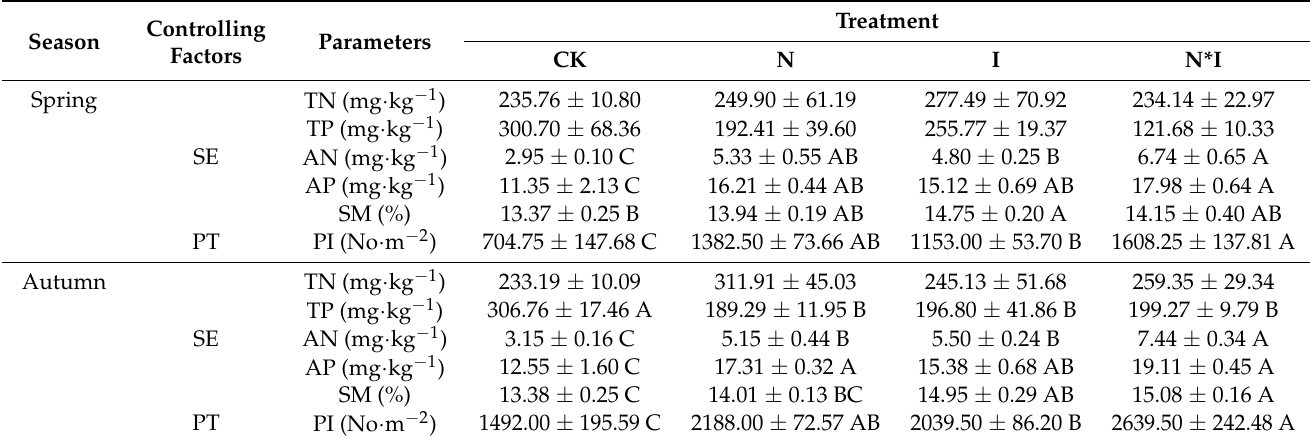
Table A1. Different treatment effects on parameters in spring and autumn.